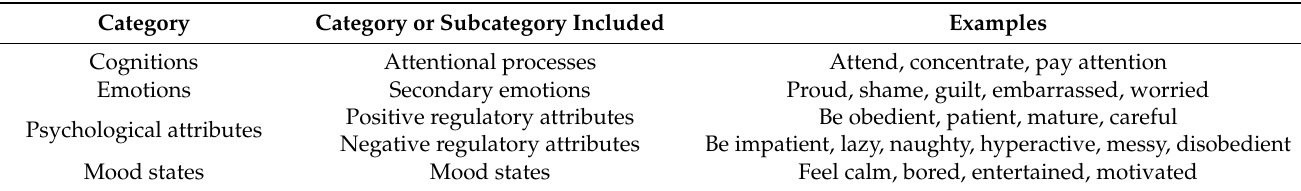
Table 1. Description of the categories considered in the